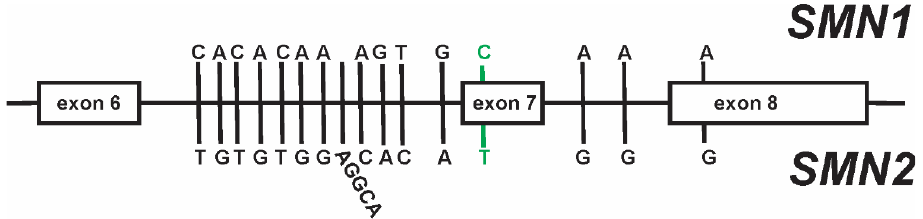
Figure 3. Paralogous sequence variants (PSVs) between SMN1 and SMN2 . The canonical PSV at exon 7 that functionally distinguishes SMN1 from SMN2 is highlighted in green.